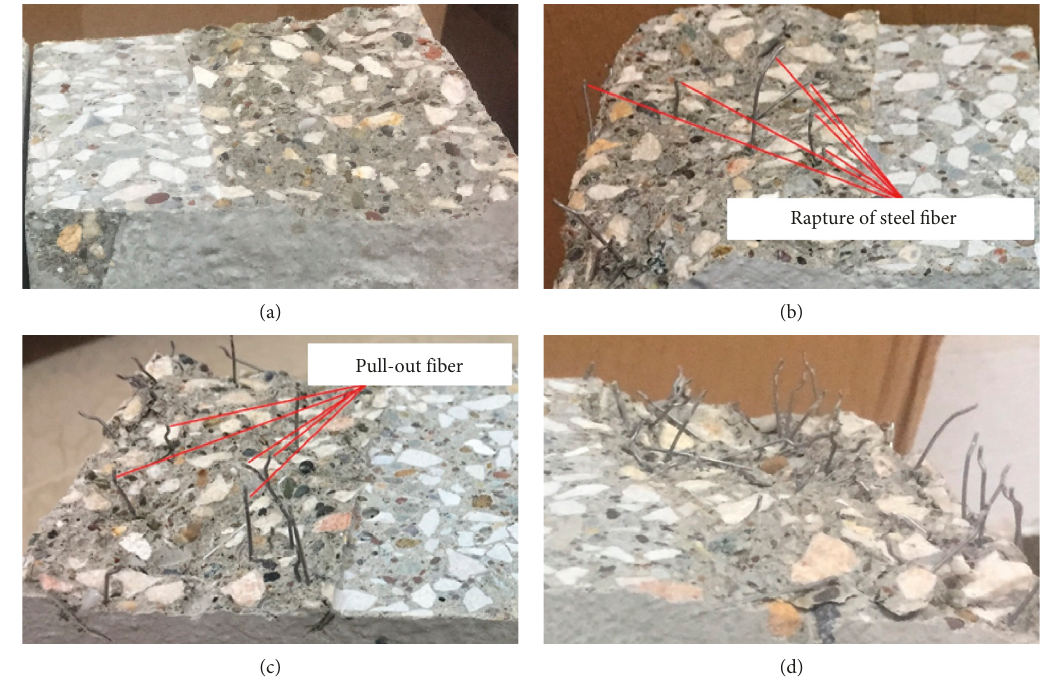
Figure 7: Fracture surfaces of the prisms with different fiber contents: (a) B0.0, (b) B0.5, (c) B1.0, and (d)